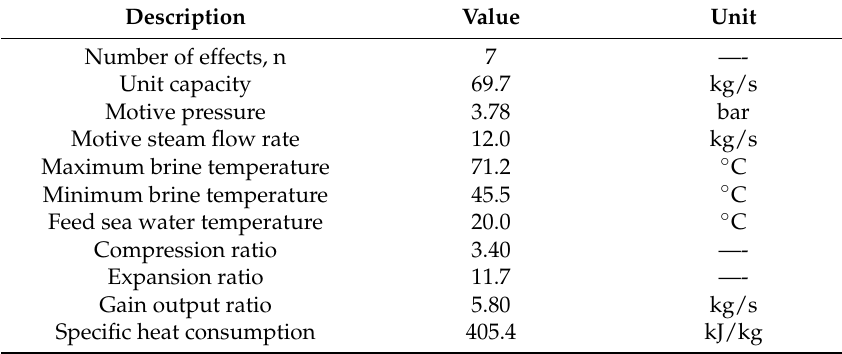
Table 1. Performance data of a single multi-effect desalination unit with thermal vapour compression (MED-TVC)